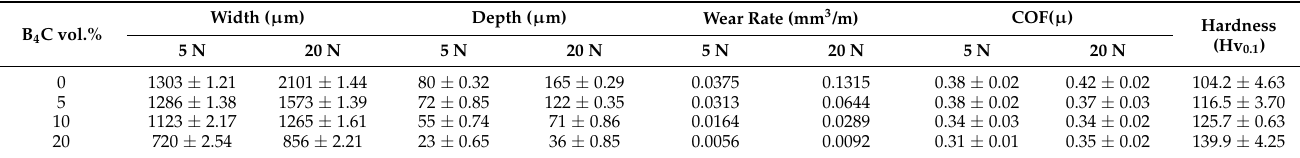
Figure 7. Comparison of coefficients of friction at ( a ) 5 N and ( b ) 20 N loads. Table 2. Summarized wear width, wear depth, COF, wear rate, and hardness of Al6061 and B 4 C/Al6061 composites.